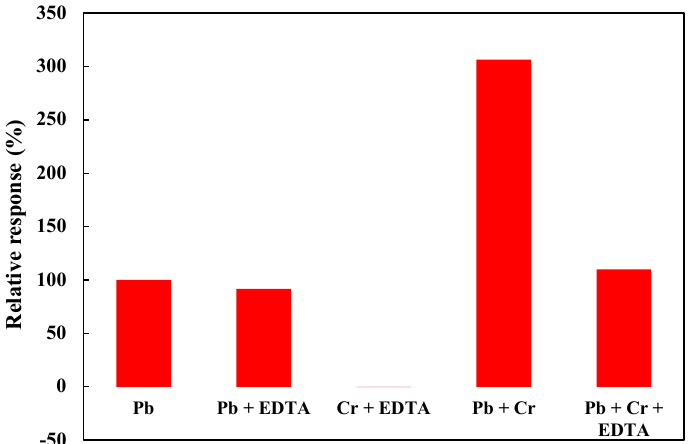
Figure 5. Selectivity test of the Pb II detection method showing the relative response of each metal ion with respect to Pb II (set as 100%). Fourteen interfering ions were tested in the presence of 1.0 µM each and the error bars represent the standard deviation of four replicates.